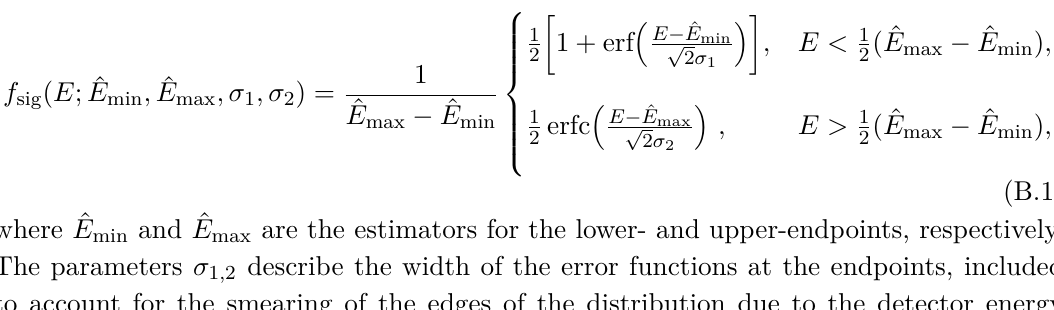
(normalized) signal probability density function (p.d.f.) for a lepton of energy E as